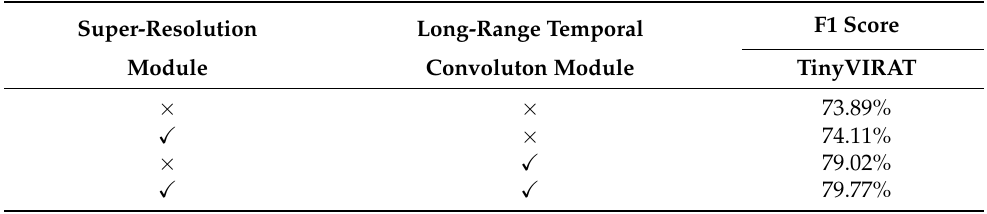
Table 3. Performance of our proposed method with/without two mechanisms on TinyVIRAT.